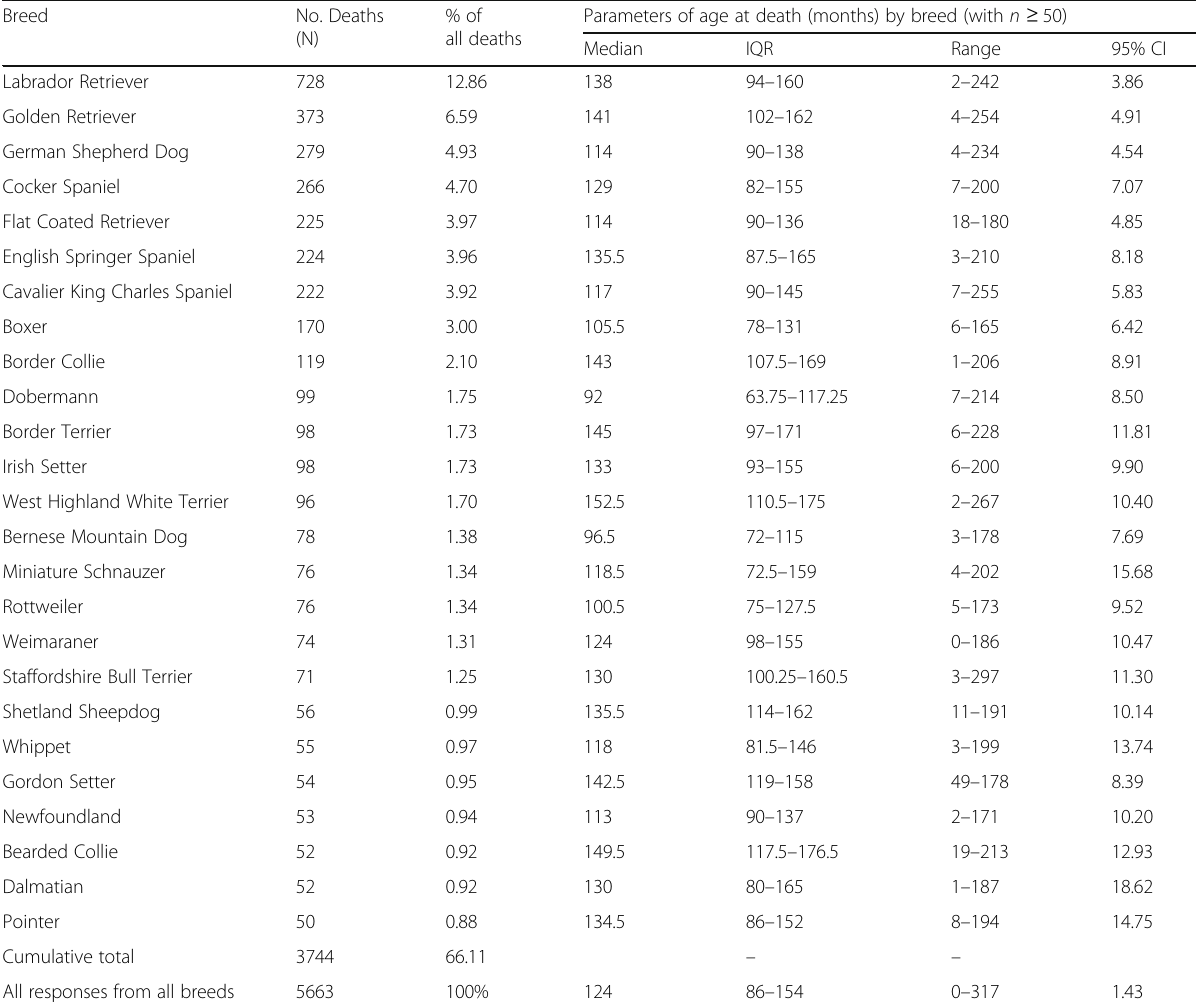
Table 1 Age at death statistics of the 25 breeds (with > 50 reported deaths), including the number of deaths reported (N), the contribution per breed (as a percentage of all deaths reported in the survey), the median, inter-quartile range (IQR), range (minimum and maximum) and 95% confidence interval of the median of age of death in